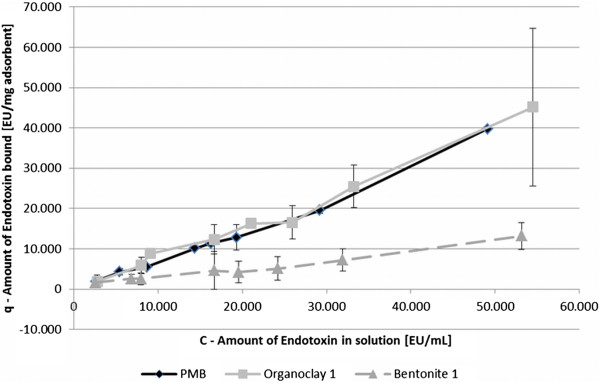
The relationship between adsorption capacity (q) and amount of endotoxin in solution (C) of different sorbents. Error bars represent the minimum and maximum measured amount of endotoxin bound within two independent replicates.